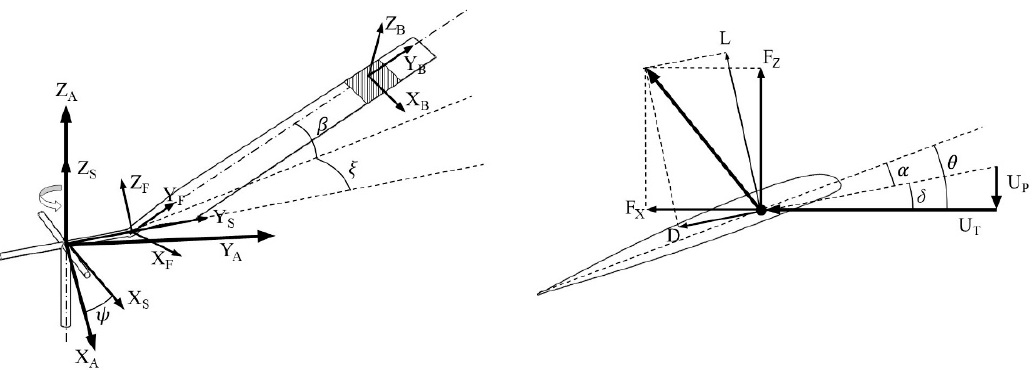
Figure 2. Reference frames for the blade load prediction.